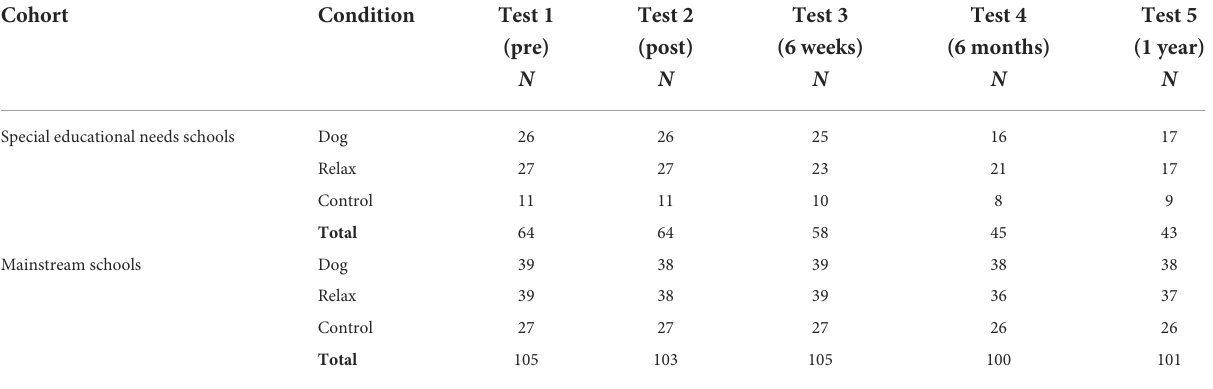
TABLE 1 Number of children taking part in the test task at each assessment point per condition and school